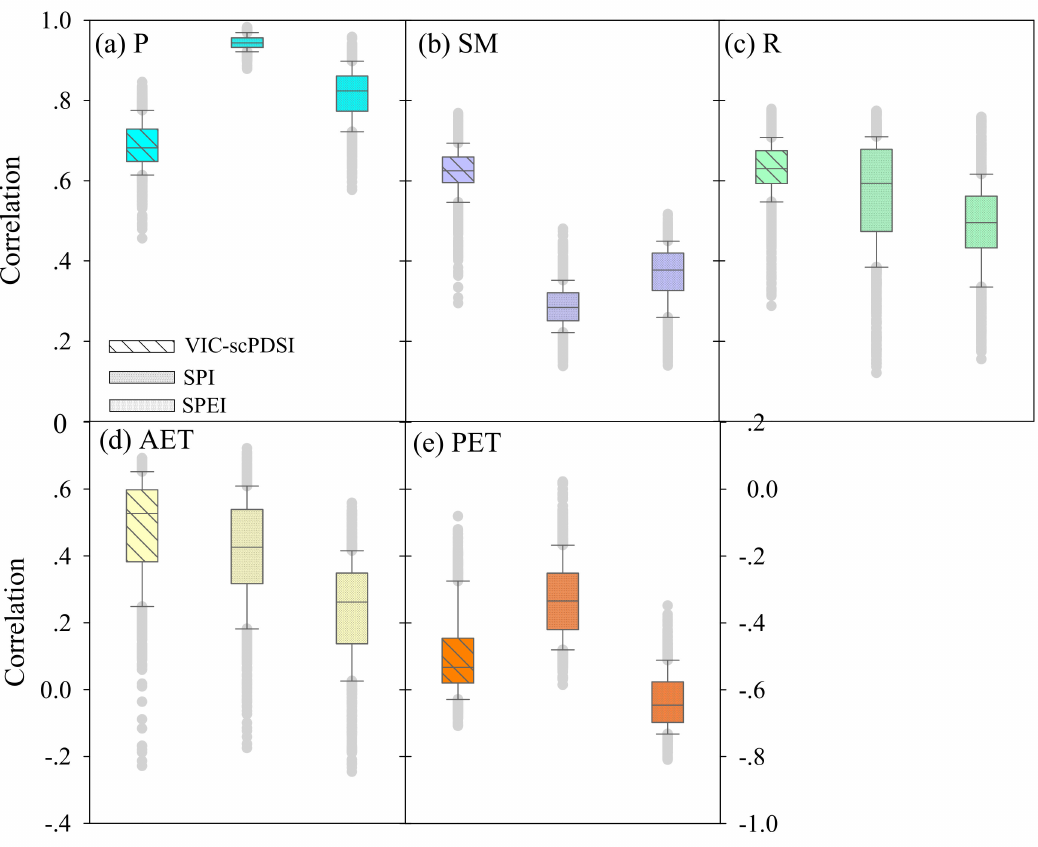
Figure 9. The boxplots of correlation coefficients between VIC-scPDSI9, SPI3, SPEI3 against five hydrological